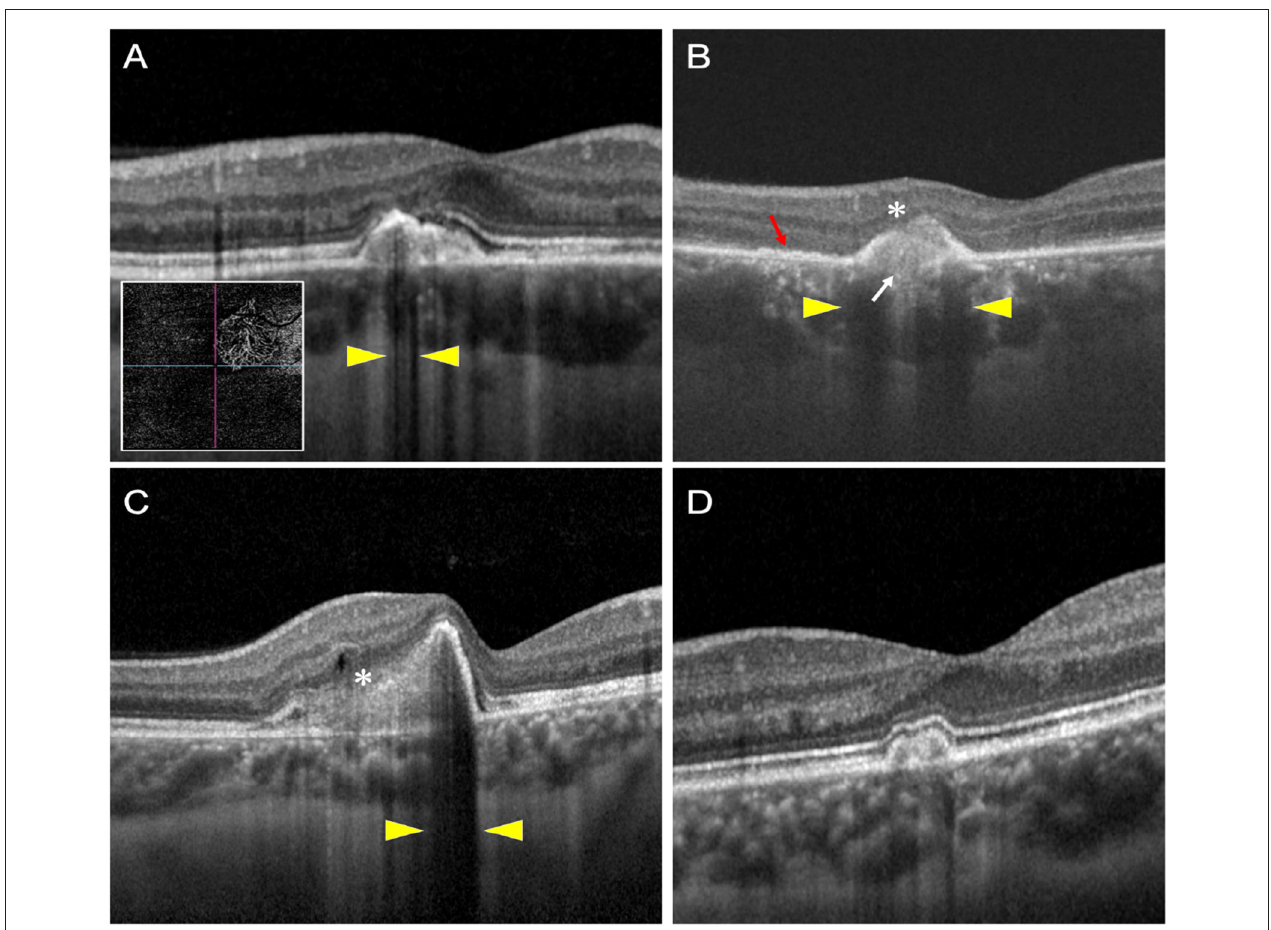
FIGURE 2 | This figure shows examples of optical coherence tomography (OCT) scans of patients with PIC with and without choroidal neovascularization (CNV). (A–C) Show three patients with CNV, and (D) shows a patient without an underlying CNV. The OCT scan (A) shows hypo-reflective choroidal back-shadowing (yellow arrowheads). The inset shows an OCT angiography image with a large CNV network. OCT scan (B) shows a patient with outer retinal fuzziness (white asterisk), disruption of the ellipsoid zone (red arrow), disruption of the BM (white arrow), and hypo-reflective choroidal back-shadowing (yellow arrowheads). OCT scan (C) shows a third patient with fuzzy infiltration of the outer retina (white asterisk), a small intraretinal cystoid space, and hypo-reflective back-shadowing (yellow arrowheads). OCT scan of another patient with no underlying CNV shows none of these